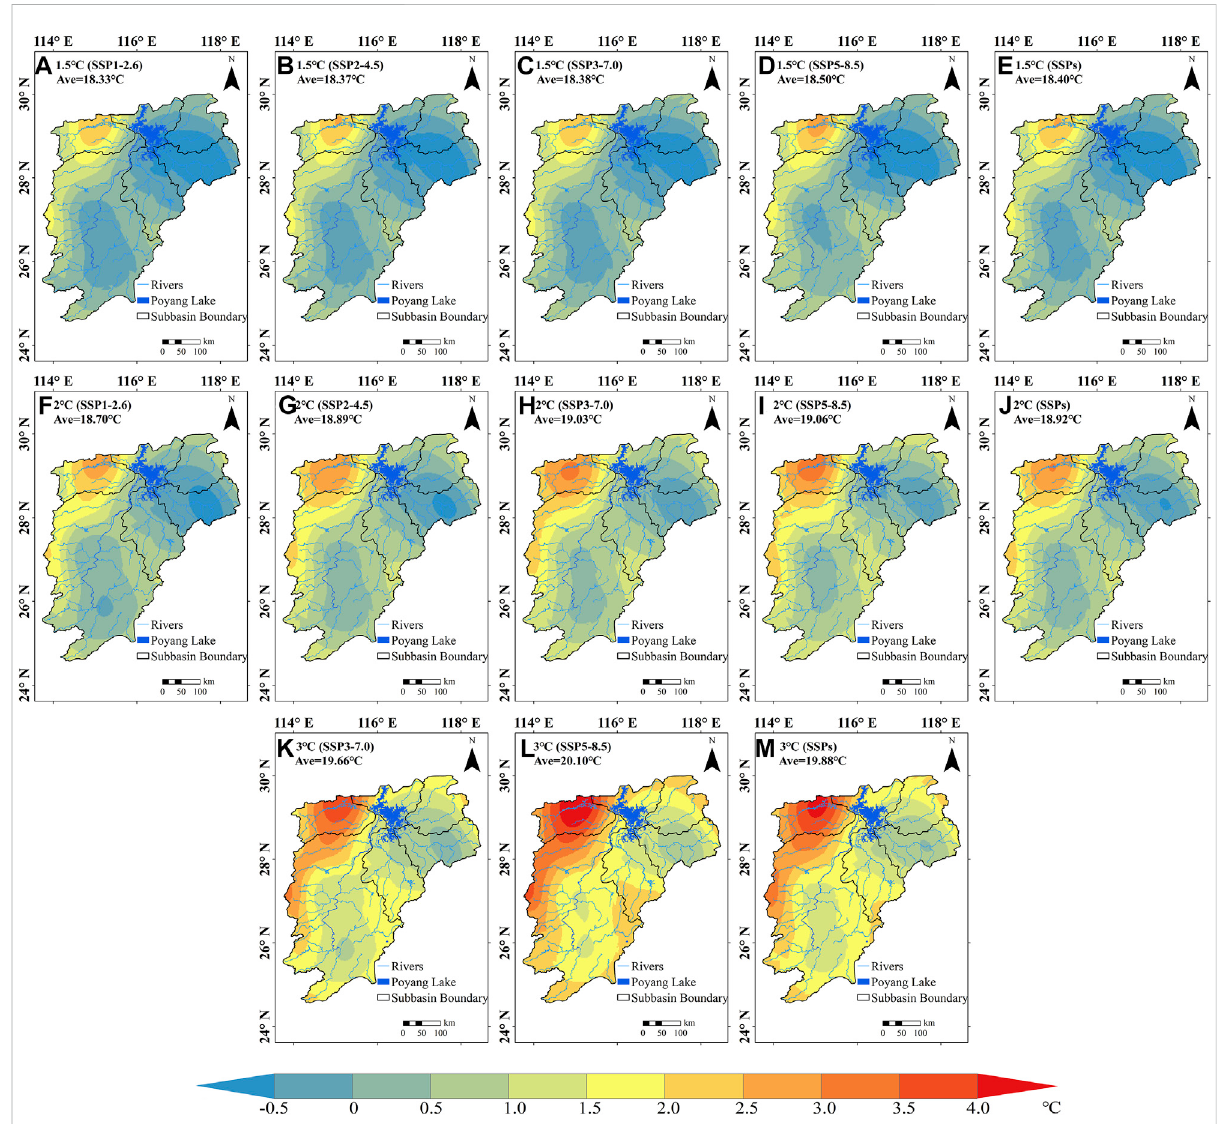
FIGURE 8 Spatial distribution of Tas in the PLB relative to the reference period (1986 – 2005). (A – E) are the 1.5 ° C global warming target. (F – J) are the 2 ° C global warming target. (K – M) are the 3 ° C global warming target. (E,J,M) are the emission scenarios averaging results.